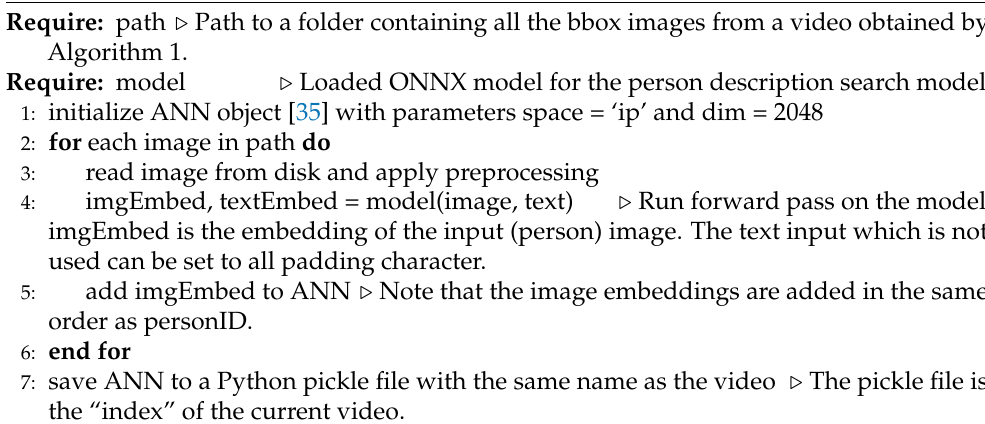
Algorithm 2 Building ANN Structure for Fast Person Description Search